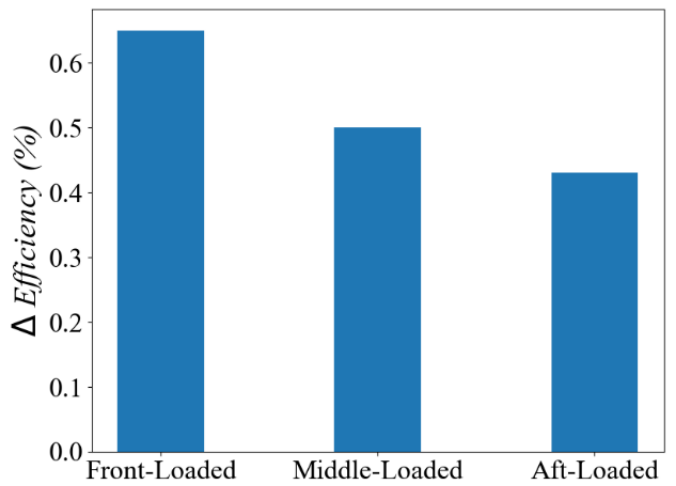
Figure 18. Efficiency improvement with three loading distributions, at design speed and design pressure ratio.